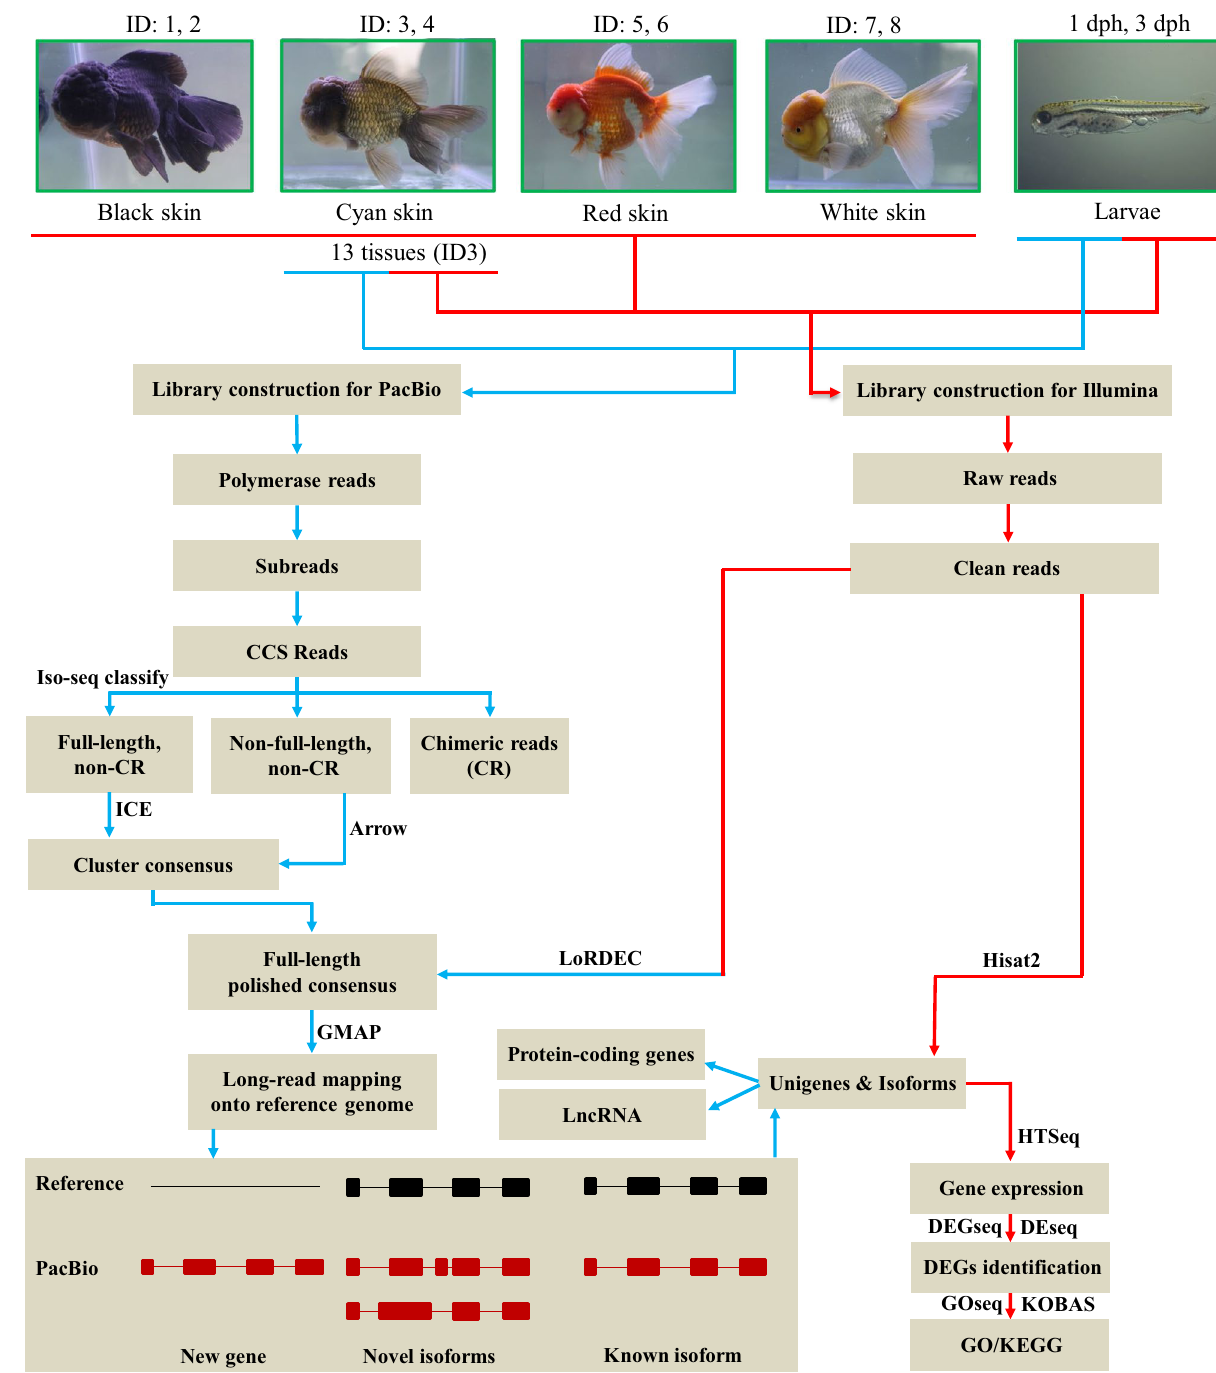
Figure 1. Overview of the experimental design and the data processing pipeline. This study consisted of experimental design, library construction and sequencing, and data processing and analyses. Goldfish samples include 13 tissues from one cyan fish, four color skins and larvae at 1 and 3 dph. All 22 samples were subject to Illumina sequencing, and only 13 tissues from one cyan fish and larvae at 1 and 3 dph were used for PacBio sequencing. The figures were constructed in Microsoft Office